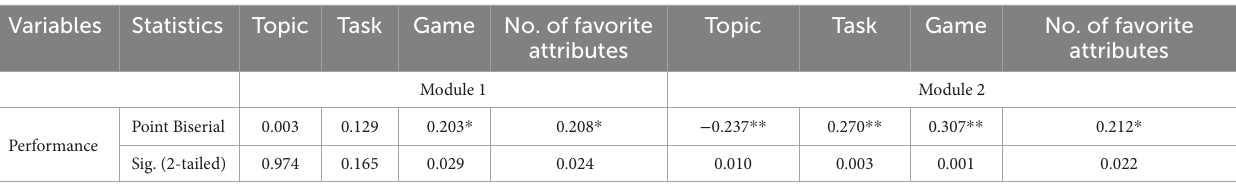
TABLE 4 Point-biserial correlation result of the favorite module